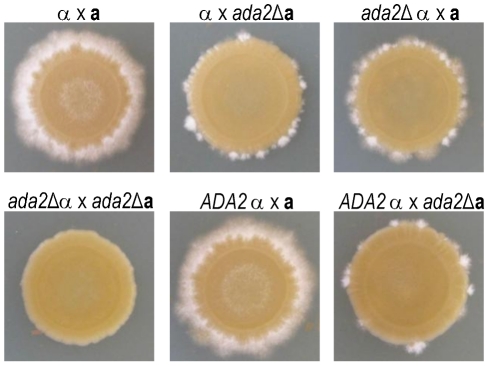
Ada2 is required for normal hyphal development.Wild type (no strain designation), ada2Δ, and complemented ada2Δ (ADA2) strains of opposite mating type were mixed and grown under conditions that induce mating (see Methods). Patches were imaged after 13 days.